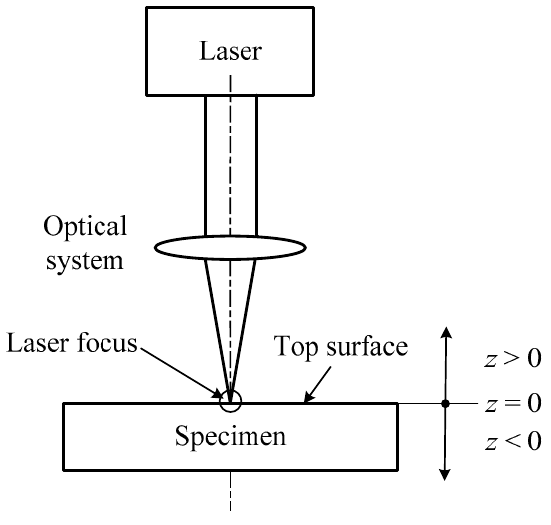
Figure 2. Schematic setup of laser spot welding of sintered NdFeB.